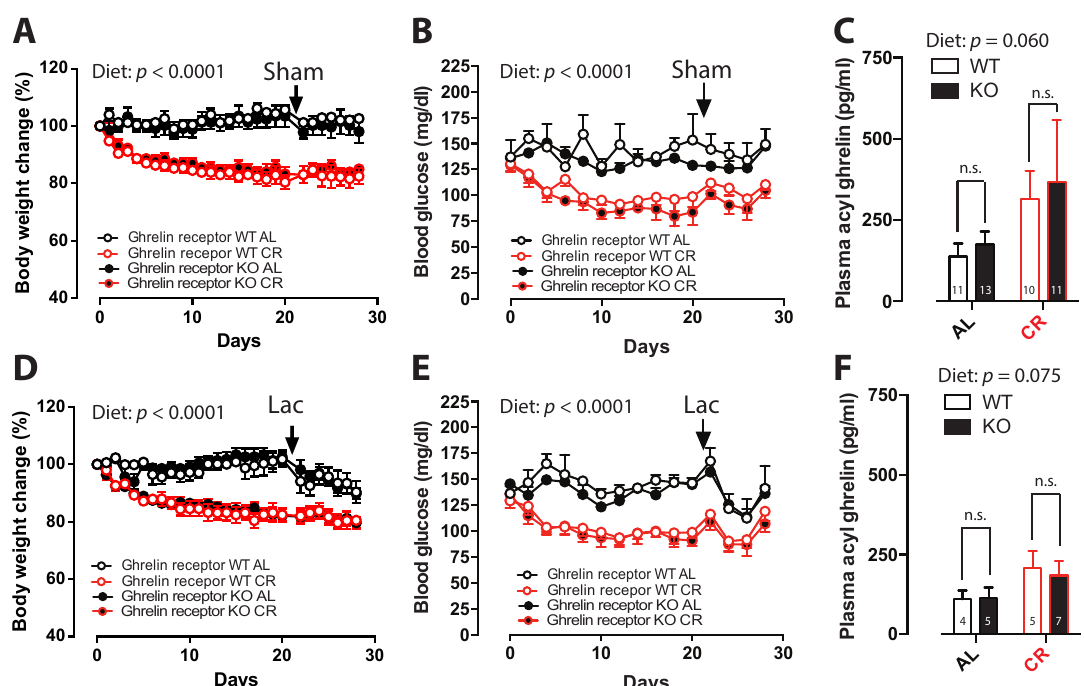
Figure 2. The effect of caloric restriction on ( A , D ) body weight (relative to day 0); ( B , E ) blood glucose levels; ( C , F ) and plasma acyl-ghrelin levels in sham- ( upper panels) and LAC-injected ( lower panels) ghrelin receptor WT and KO mice under a caloric restriction (CR) or ad libitum (AL) feeding regimen. The arrow shows the day of intranigral sham or lactacystin (LAC) injection. (Two-way ANOVA followed by a post-hoc Sidak’s multiple comparison test, panel A , D , E : Diet (AL versus CR) p < 0.0001, time-effect p < 0.0001; panel B : Diet (AL versus CR) p < 0.001, time-effect p < 0.0001; panel C : Interaction p = 0.913, Diet (AL versus CR) p = 0.060, Genotype p = 0.554; panel F : Interaction p = 0.747, Diet (AL versus CR) p = 0.075, Genotype p =